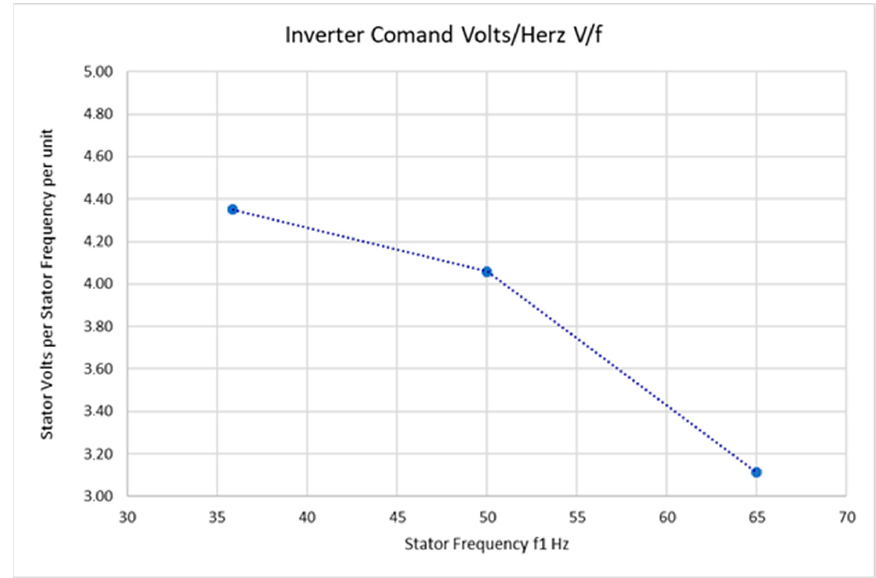
Figure 16. Stator Voltage per Stator Frequency / V f vs. stator frequency of IM.